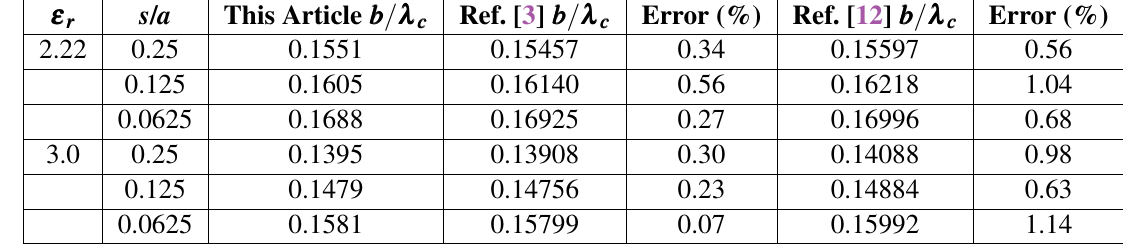
/ a ) of dominant mode and bandwidth ( λ c